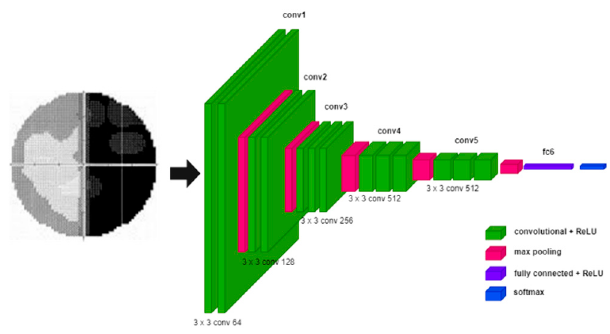
Figure 4. VGG-Net Model.